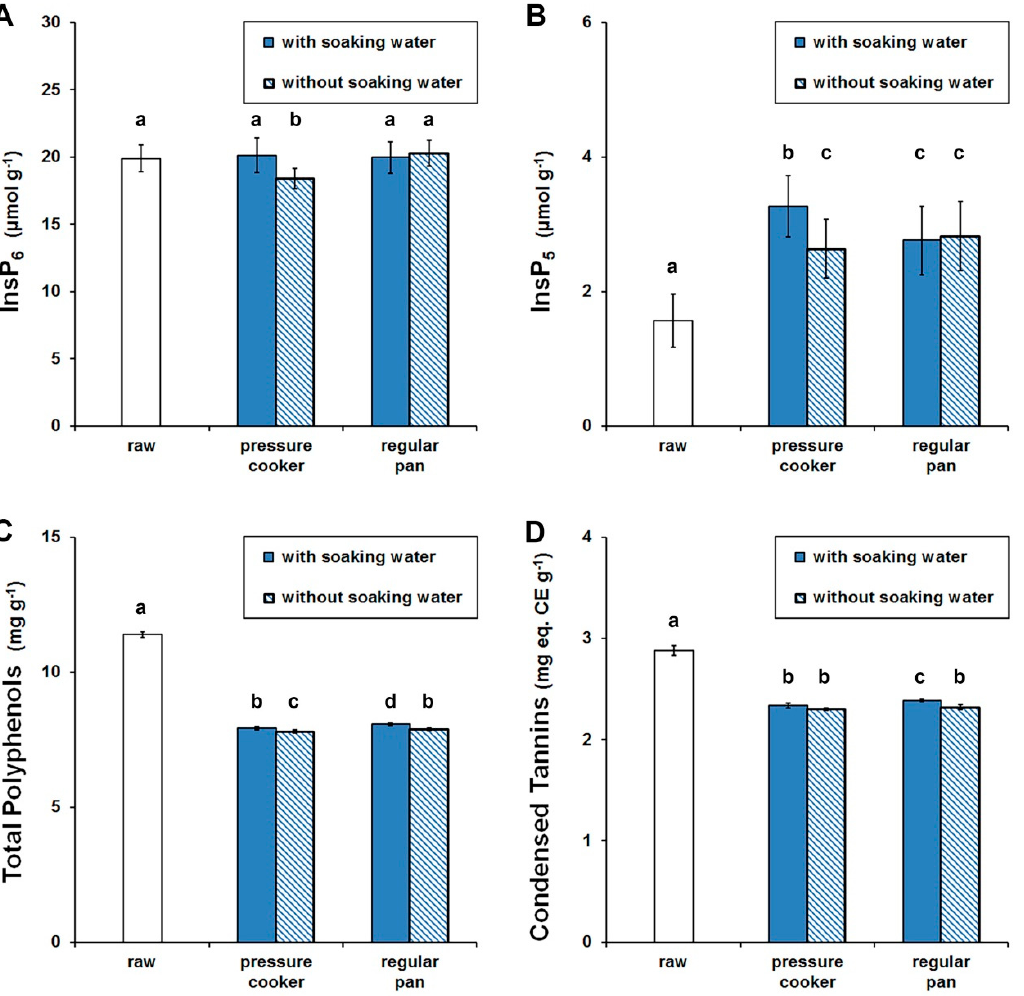
Figure 2. Black bean anti-nutrients content of InsP 6 ( A ), InsP 5 ( B ), total polyphenols ( C ) and condensed tannins ( D ). Data expressed as mean ± standard deviation (dry matter). Values marked by different letters are significantly different ( p < 0.05).